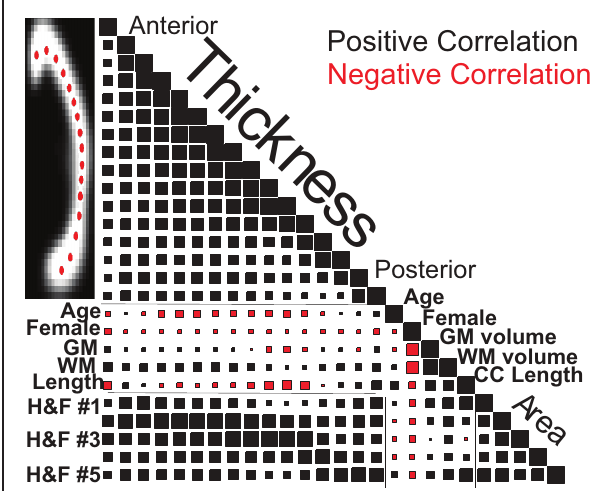
FIGURE 8 | Spearman correlation values for callosal thicknesses at 16 locations (Ant: anterior, Pos: posterior), regional callosal areas (within 5 H&F partitions: see Figure 3), and callosal length along with estimated GM and WM volumes, age and gender for the 1231 FCP subjects. Square areas are proportional to correlation values, both positive (black) and negative (red), with correlations of 1.0 on the diagonal for scale.